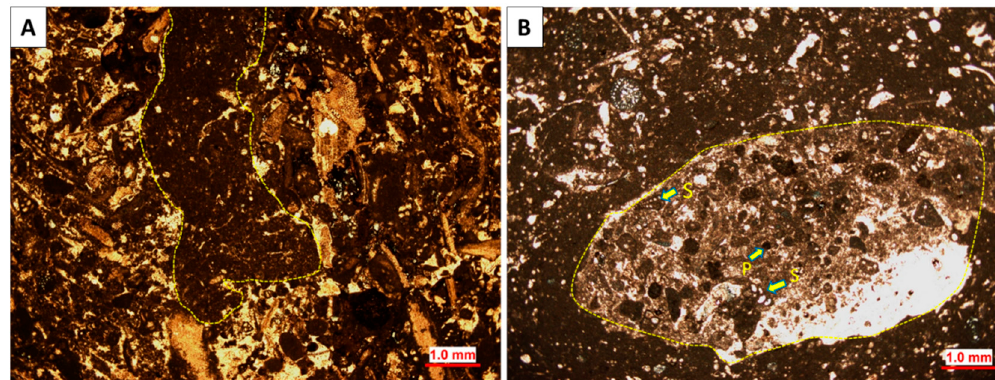
Figure 6. Thalassinoides burrows of the Hanifa Formation. Outcrop photos showing burrows filled with coarser materials than matrix ( A ), or partially to completely unfilled burrows ( B ). Pen ( A ) and hammer for scale ( B ). Scan of two of the studied samples showing burrows filled with ( C ) fine material in grain-dominated matrix highlighted by red dotted lines, and ( D ) coarse fill in mud- dominated matrix. Scale bar in cm in ( C , D ).